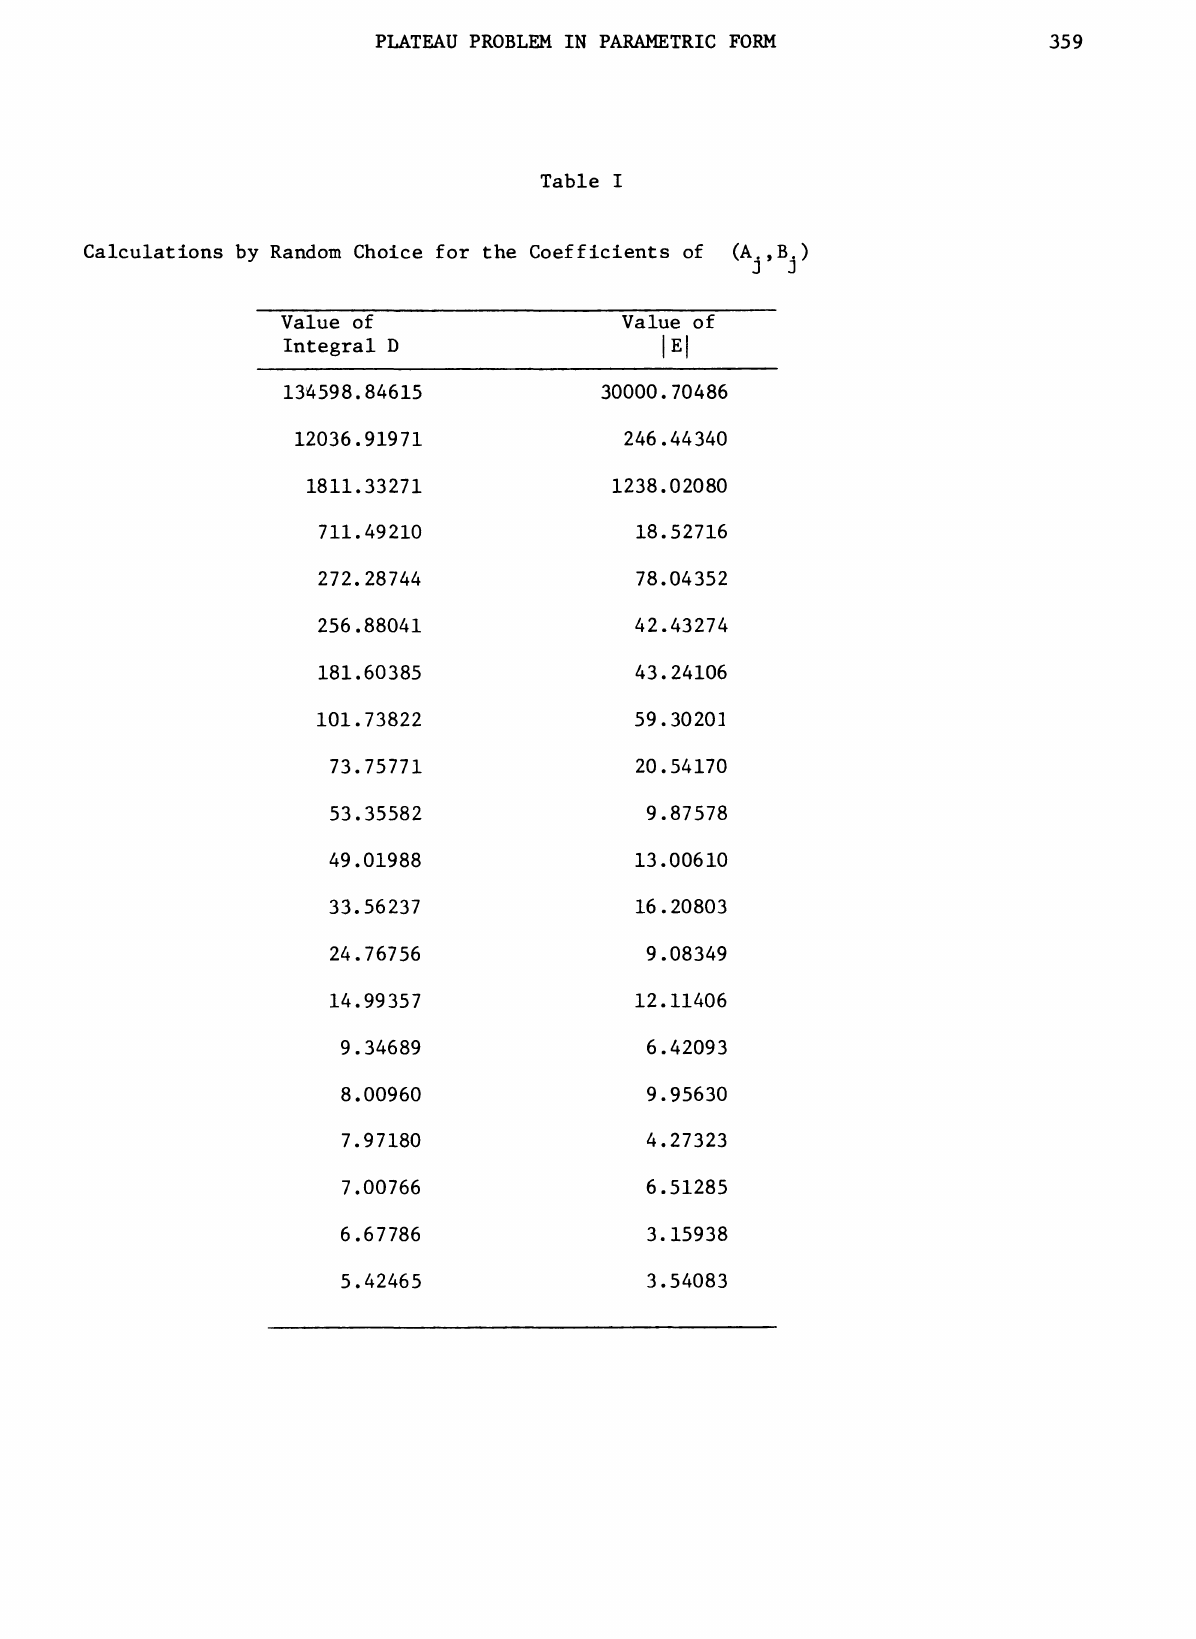
Calculations by Random Choice for the Coefficients